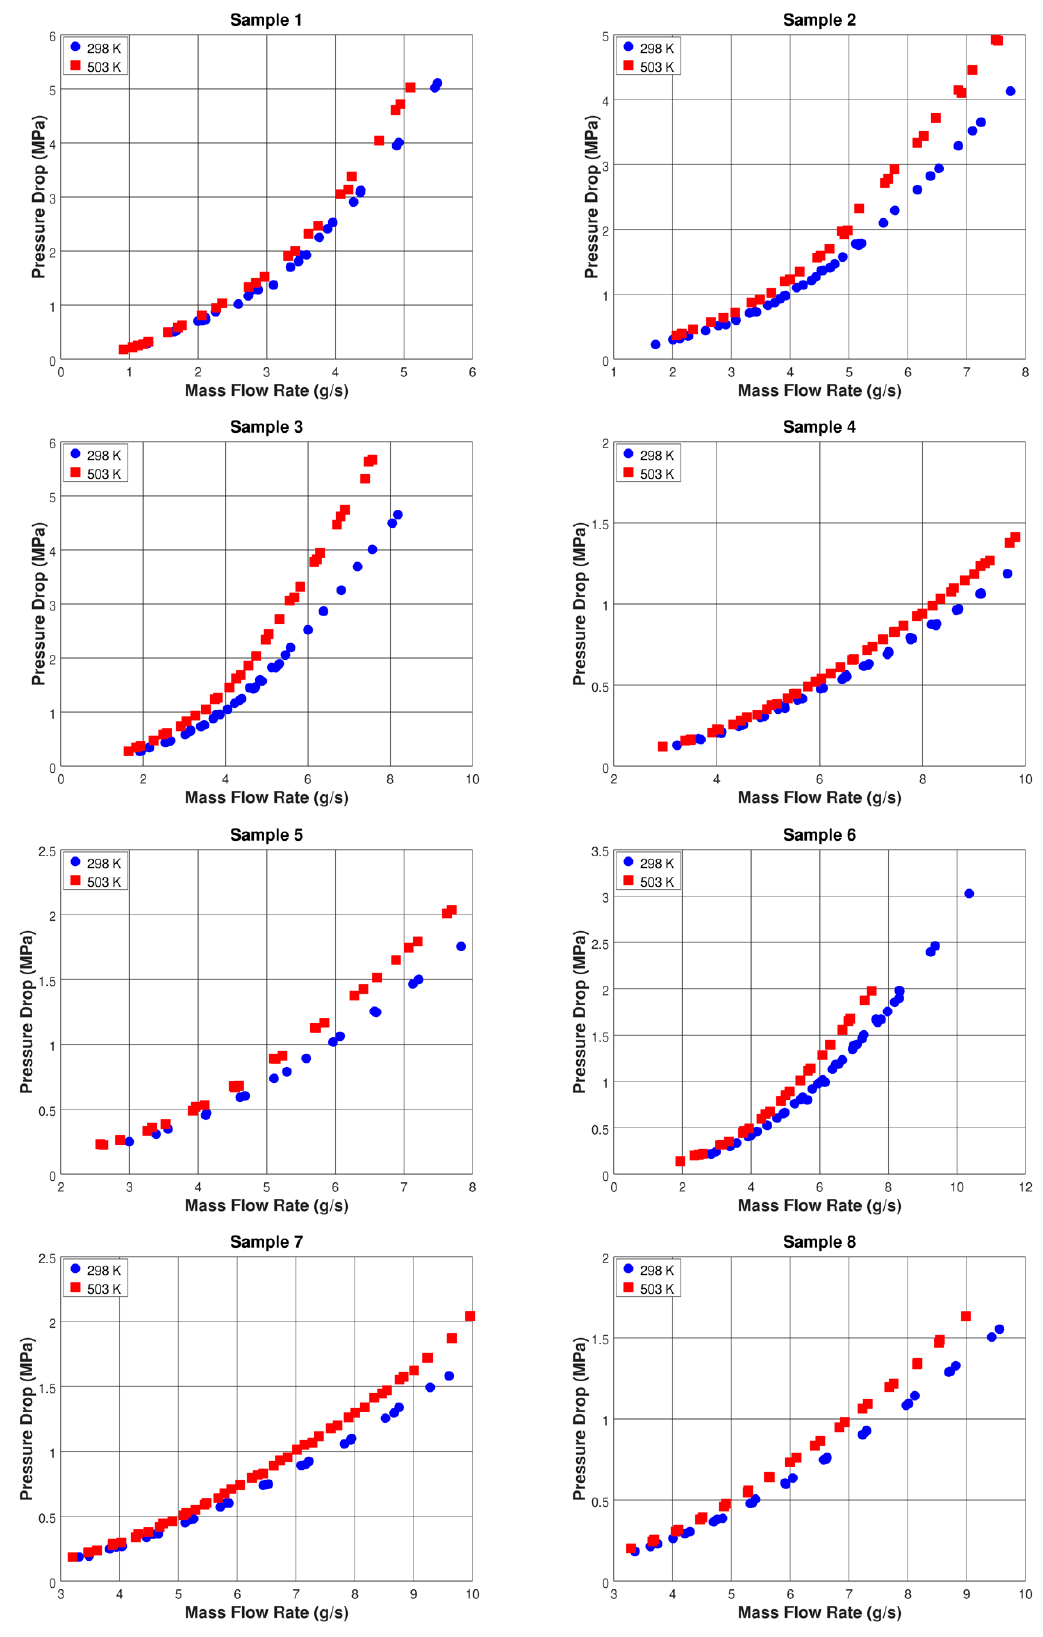
Figure 3. Discharge characteristics of the micro-orifices tested.